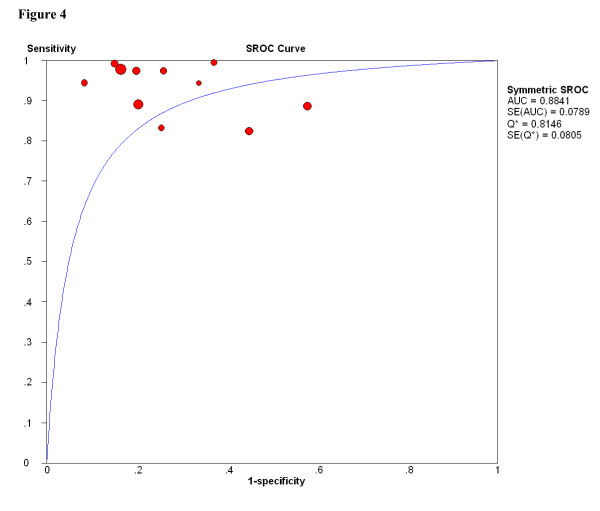
SROC curves for FANB of 11 studies which reported insufficient samples (insufficient samples was considered to be positive). Each study is represented by each solid circle in the meta-analysis. The size of the solid circle indicates the size of each study. SROC curves summarize the overall diagnostic accuracy.